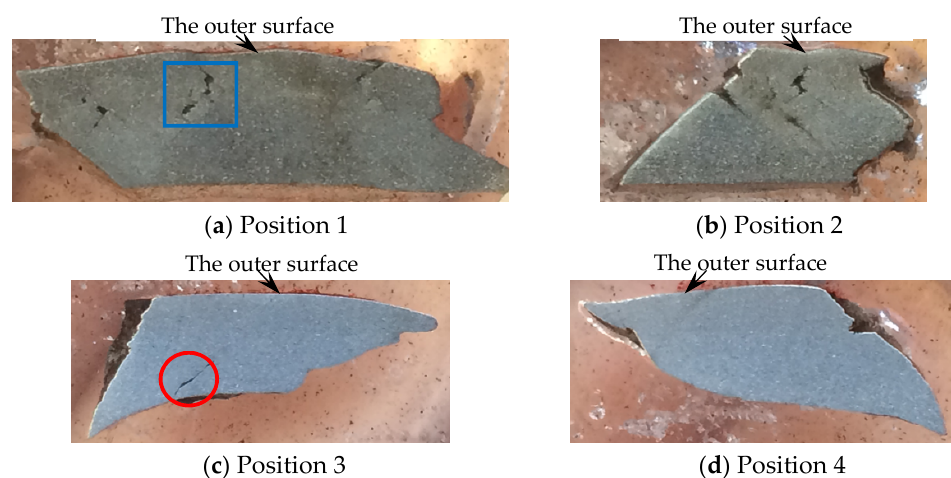
Figure 10. Cross-sections of typical fragments from different positions of Specimen 2#: ( a ) Cross-section of typical fragment from position 1; ( b ) Cross-section of typical fragment from position 2; ( c ) Cross-section of typical fragment from position 3; ( d ) Cross-section of typical fragment from position 4.